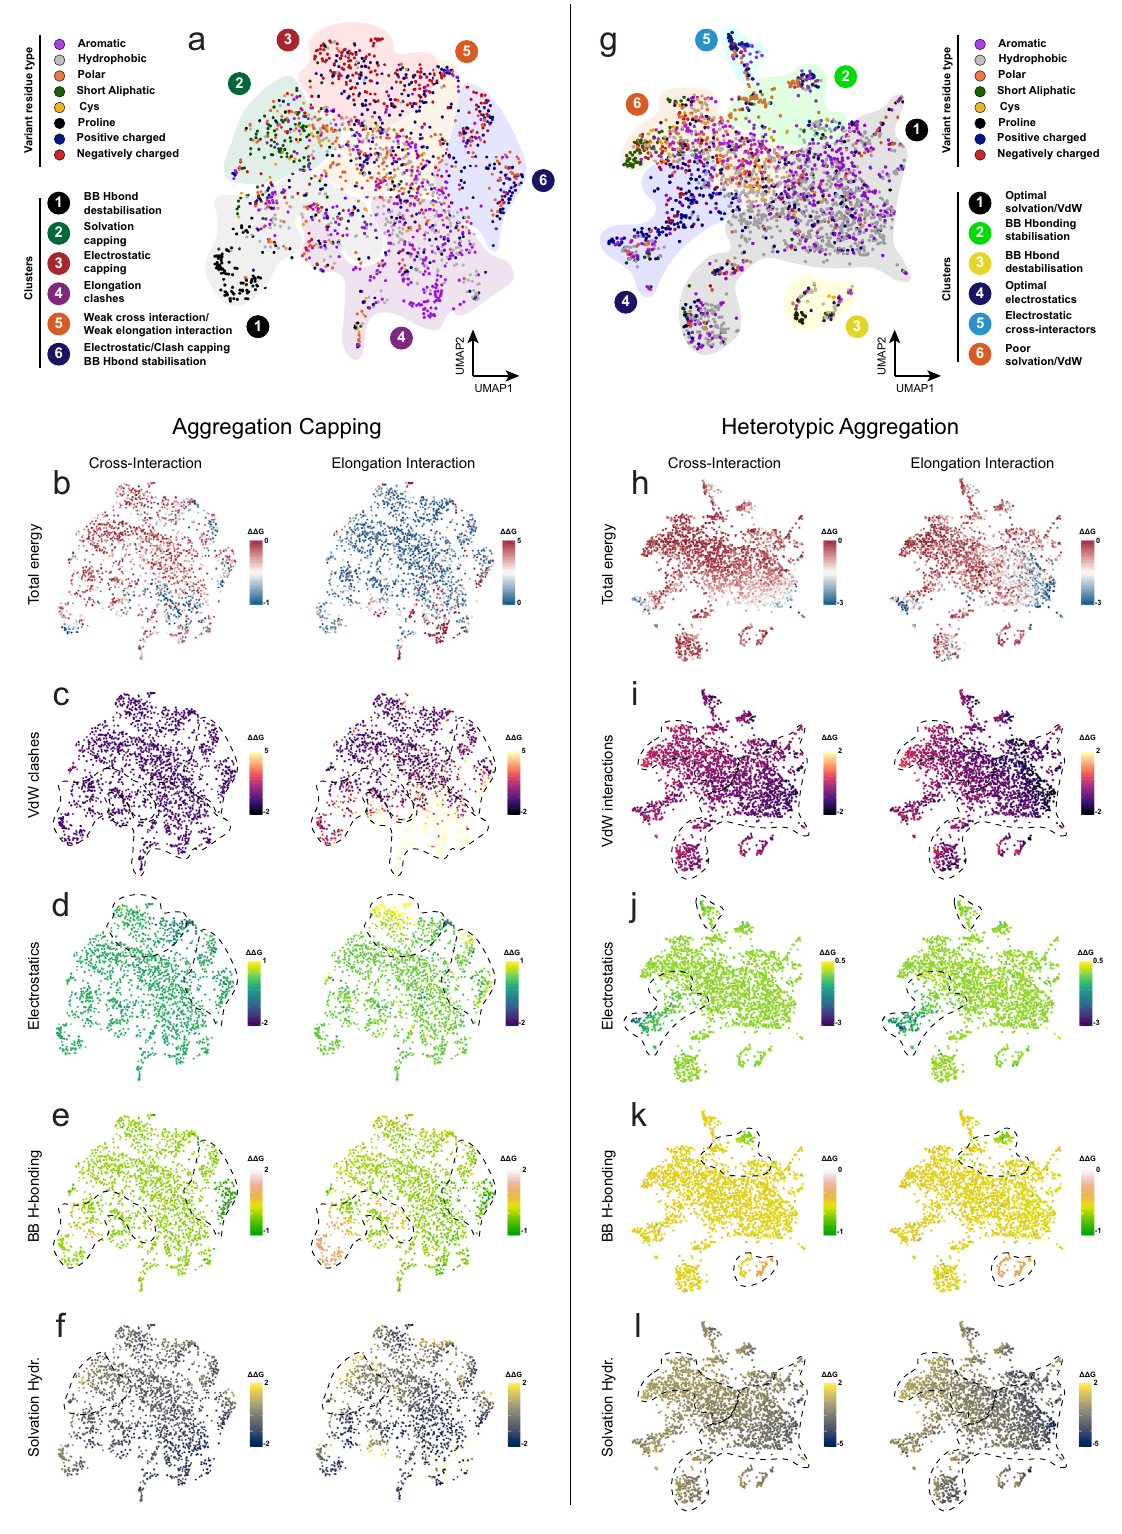
Fig. 3 Dimensionality-reduction mapping of the heterotypic sequence space. a Clustered modes of interaction that dominate capping variants were identi fi ed by analysing b total energy and individual energy components, including c steric clashes, d electrostatics, e backbone hydrogen bonding (BB H- bonding) and f solvation energy of hydrophobics. g Clustered modes of interaction that dominate variants supporting heterotypic aggregation. Independent clusters were identi fi ed by analysing h total energy and individual energy components, including i van der Waals interactions (VdW), j electrostatics, k backbone hydrogen bonding and l solvation energy of hydrophobics. ΔΔ G scales are shown in kcal mol − 1 units. Dimensionality reduction was performed using the Uniform Manifold Approximation and Projection (UMAP)